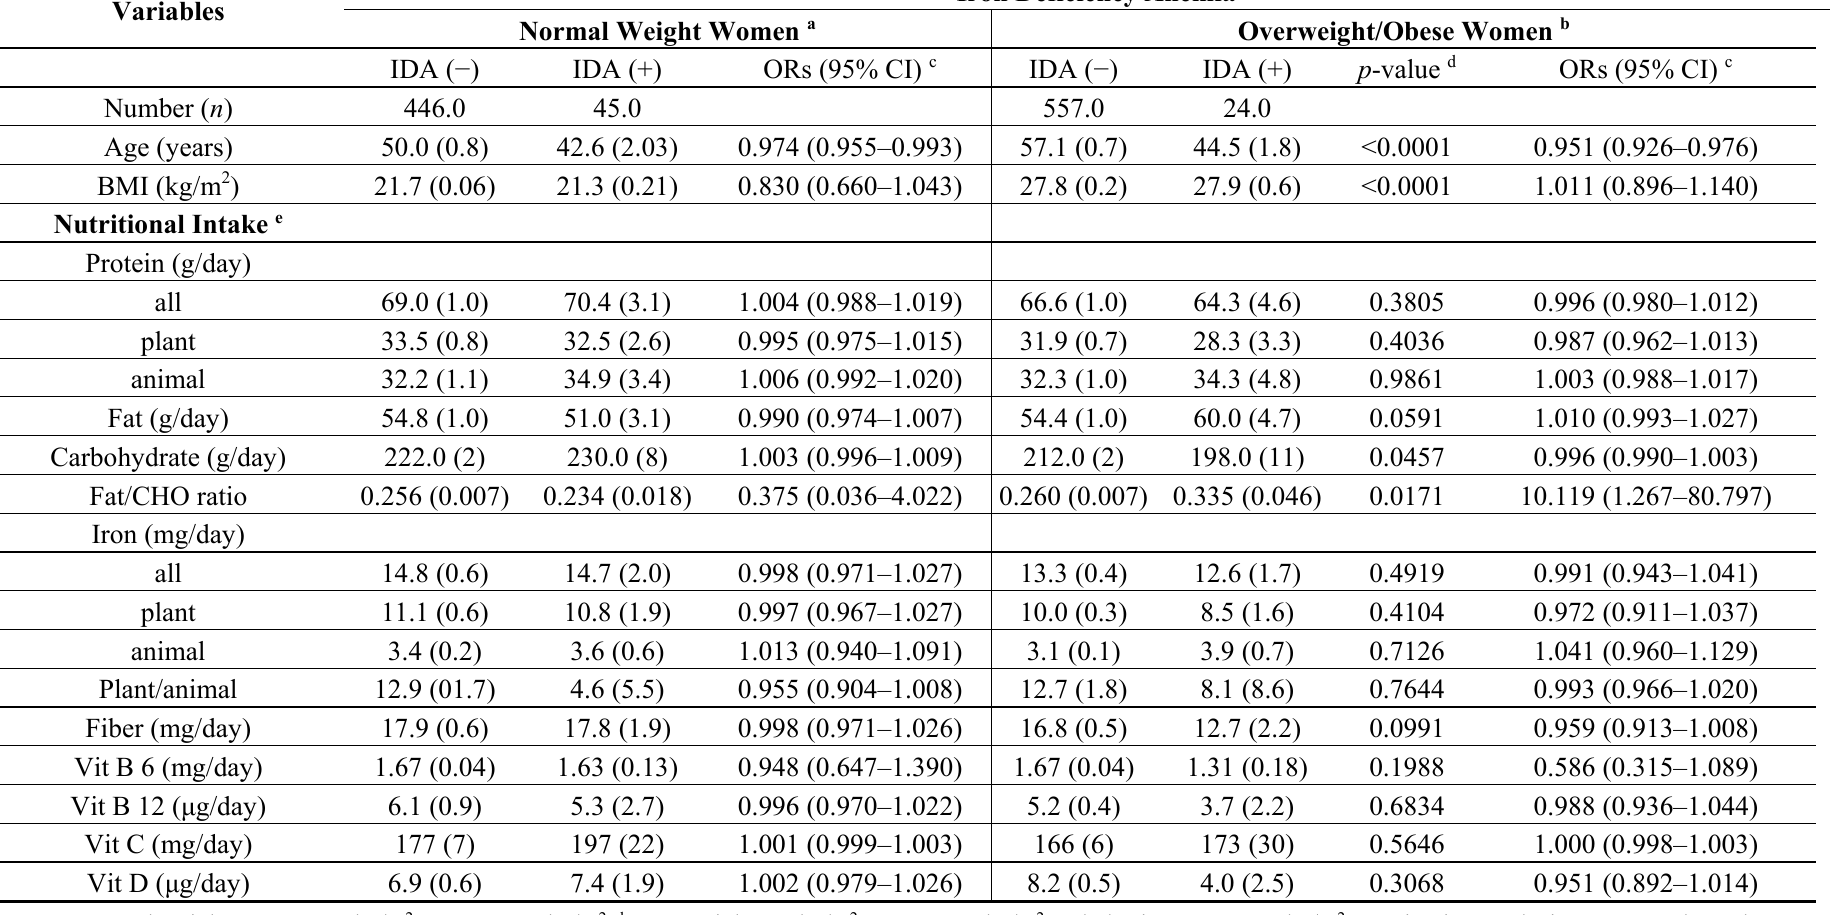
Table 2. Relationships between dietary intake, body mass index and iron deficiency anemia ( n =